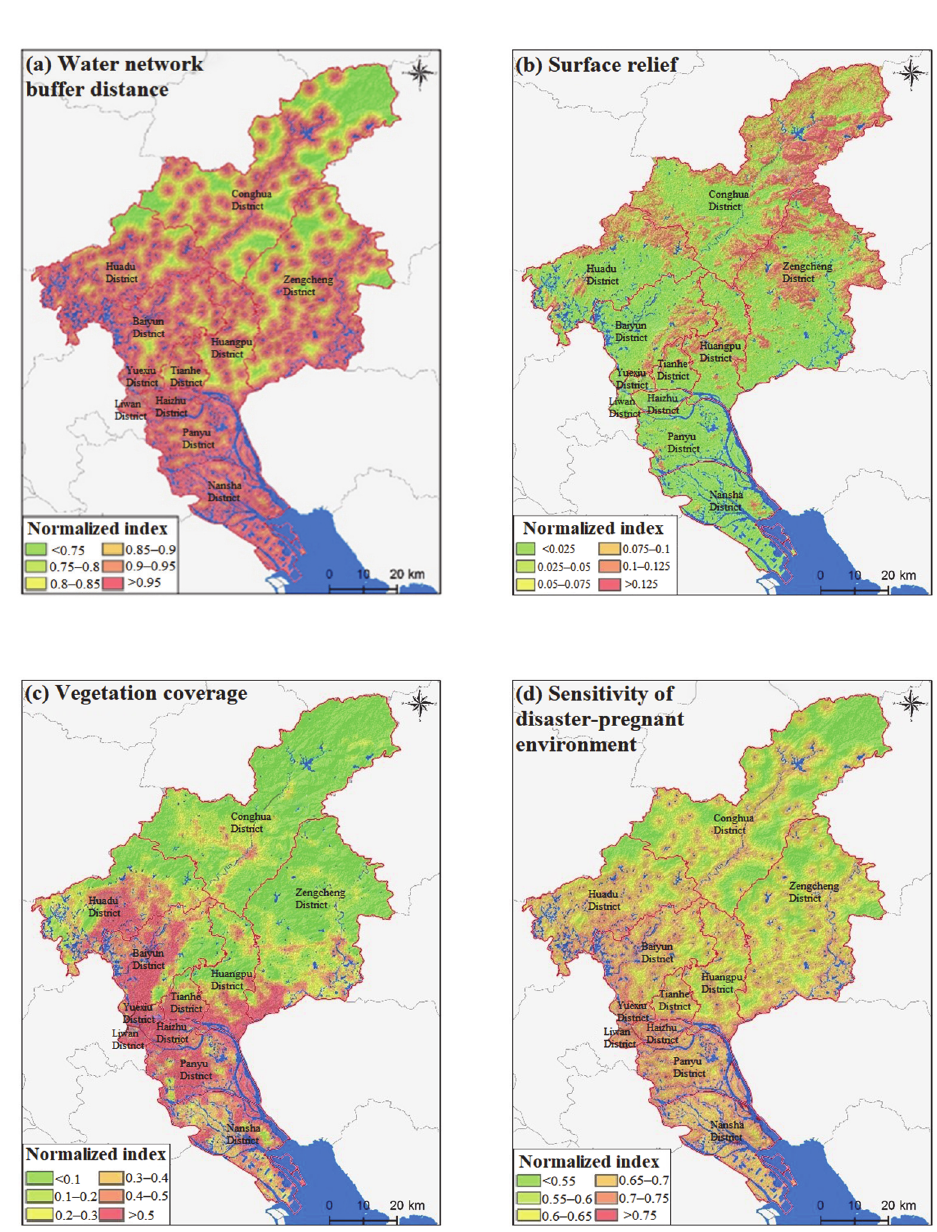
Figure 8. Sub indicators and comprehensive evaluation of environmental sensitivity to disasters: ( a ) water network buffer distance; ( b ) surface relief; ( c ) vegetation coverage; ( d ) sensitivity of the dis- aster-pregnant